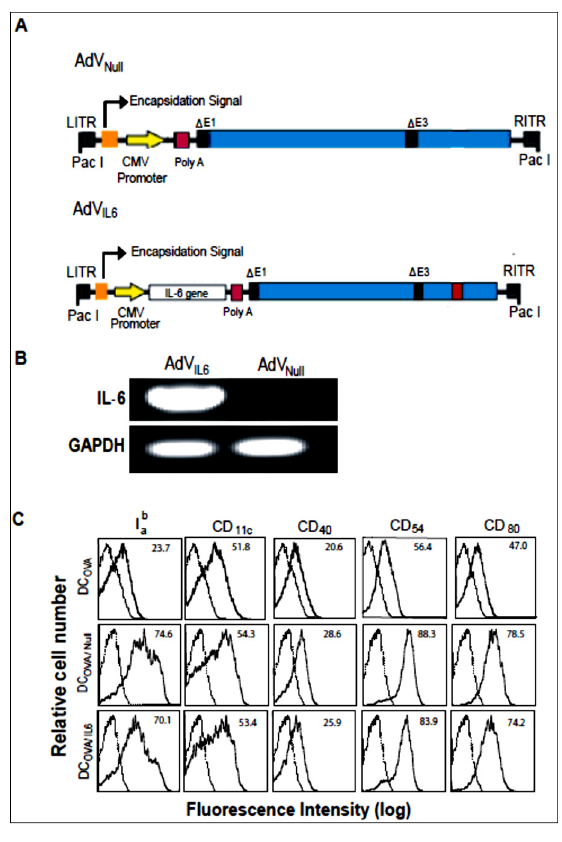
Figure 1. Phenotypic analysis of transgene IL-6 -engineered DC ( A ) Schematic OVA/ IL-6 representation of adenoviral (AdV) vector construct expressing IL-6 gene. The E1/E3 depleted replication-deficient AdV is under the regulation of the cytomegalovirus (CMV) early/immediate promoter/enhancer. ITR, inverted terminal repeat; ( B ) RT-PCR analysis of RNA obtained from AdV and AdV [ IL-6 Primer sequence: Forward 5'- ACCGC IL-6 Null TATGA AGTTC CTCTC TGC -3'; Reverse 5'- AGGCA TAACG CACTA GGTTT GC -3'] [GAPDH Primer sequence: Forward 5'- CAGGT TGTCT CCTGC GACTT -3'; Reverse 5'- CTTGC TCAGT GTCCT TGCTG -3']; ( C ) AdV transfected DCs were stained with a panel of Abs (solid lines) or isotype-matched control antibodies (dashed lines) followed by flow cytometric analysis. The value in each panel represents the percentage of positive cells based on the isotype control. One representative experiment of two is